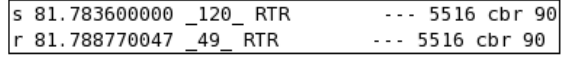
Figure 8. Packet transfer with encryption.